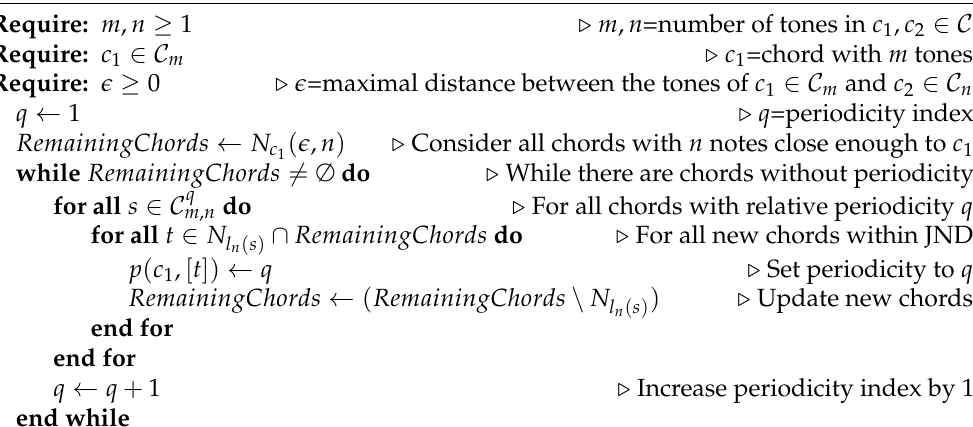
Algorithm 2 Determine transitive periodicity step function p : C × C →